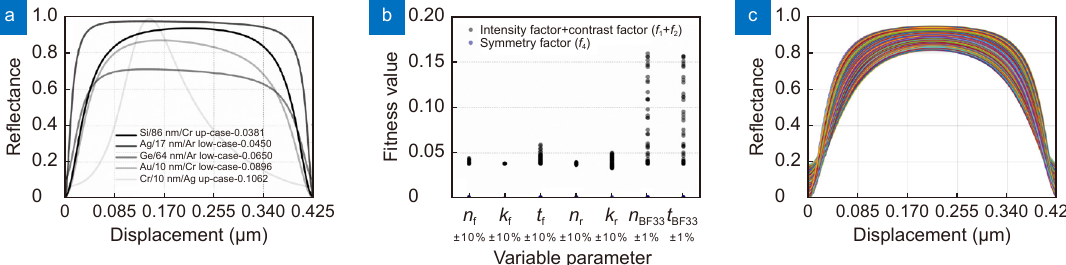
Fig. 6 | Optimization results of the symmetric design. ( a ) Light-displacement responses of 5 primary candidates among the simple substance materials for the single-layer setting. ( b ) Single-parameter tolerance analysis results of Si/86 nm/Cr up-case setting. ( c ) Responses of all multi- parameter tolerance analysis